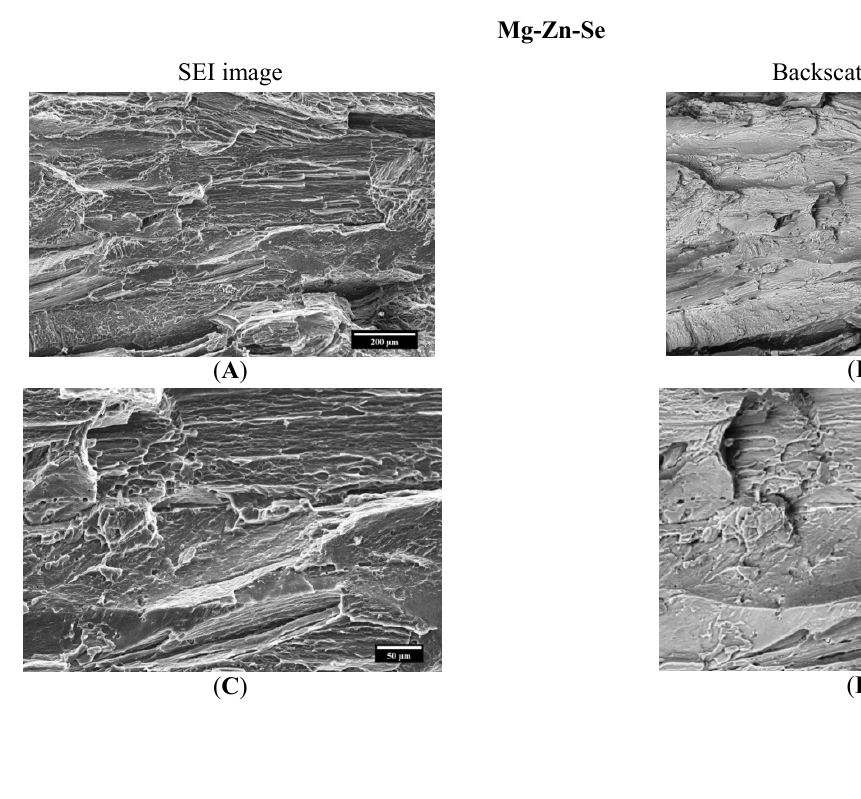
Figure 3. Comparative SEM fracture surface images for magnesium alloys after normal tensile